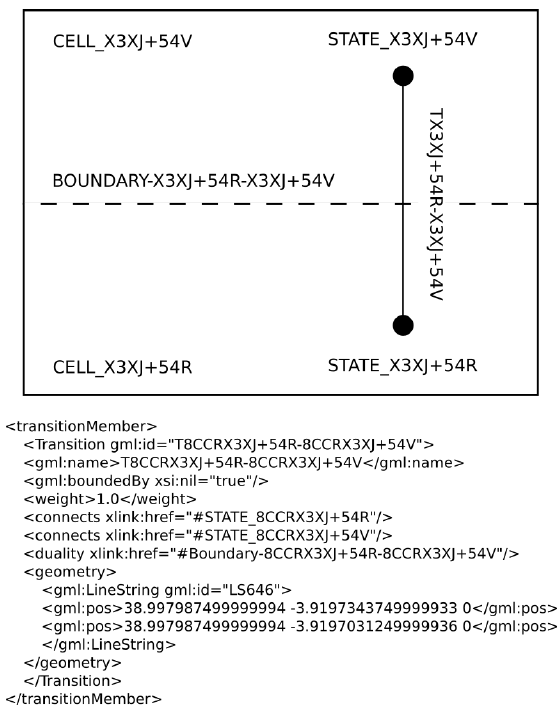
Figure 4. Example transition